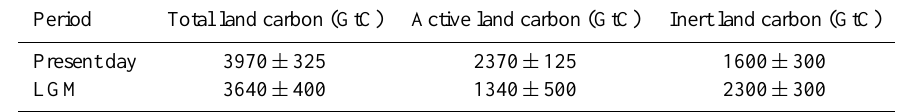
Table 5. Total land carbon stock estimates from Ciais et al. (2012).